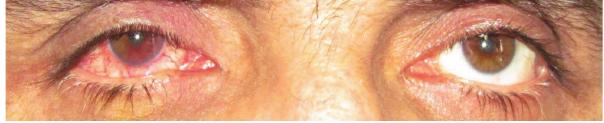
Figure 1. Primary presentation: Conjunctiva and ciliary injec- tion of the right eye.